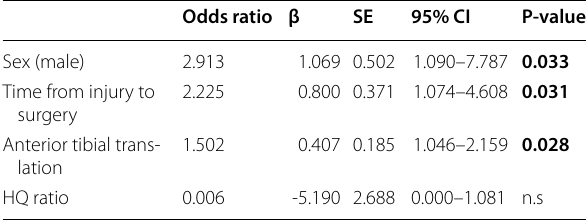
Likelihood ratio test, P Nagelkerke R 2